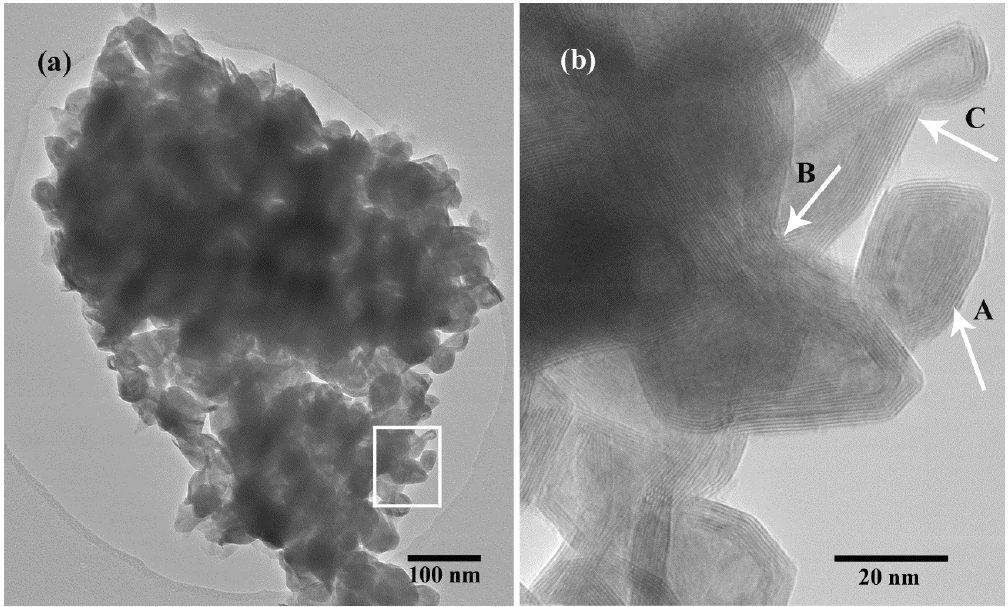
Figure 8. TEM images of the WS zoomed-in image of framed area in